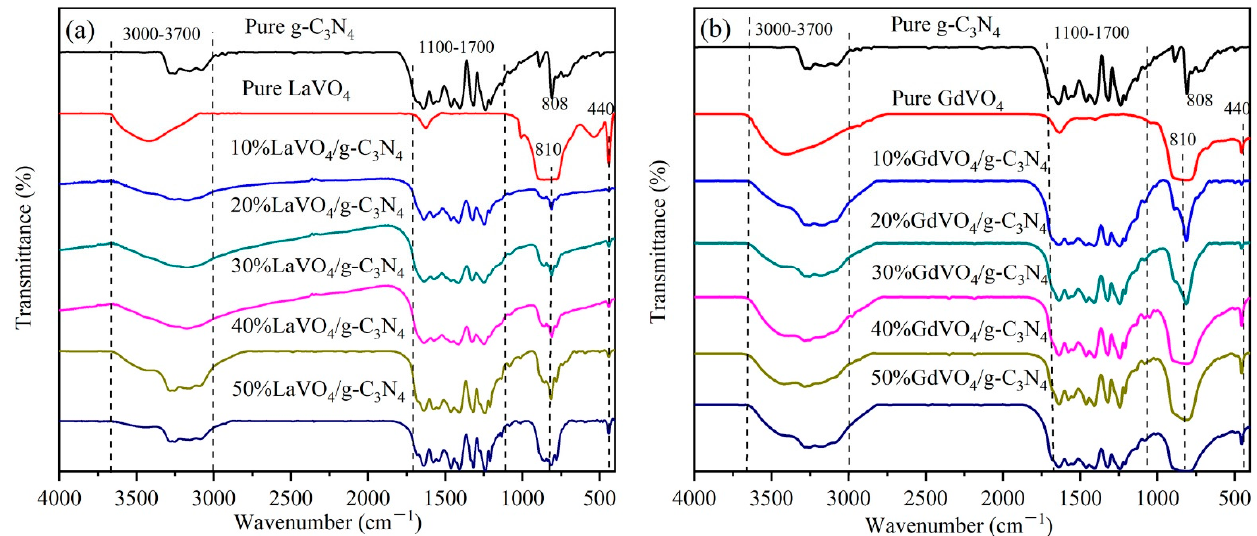
Figure 3. FT-IR absorbance spectra of ( a ) g-C 3 N 4 , LaVO 4 , and 10–50%LaVO 4 /g-C 3 N 4 , ( b ) g-C 3 N 4 , GdVO 4 , and 10–50%GdVO 4 /g-C 3 N 4.